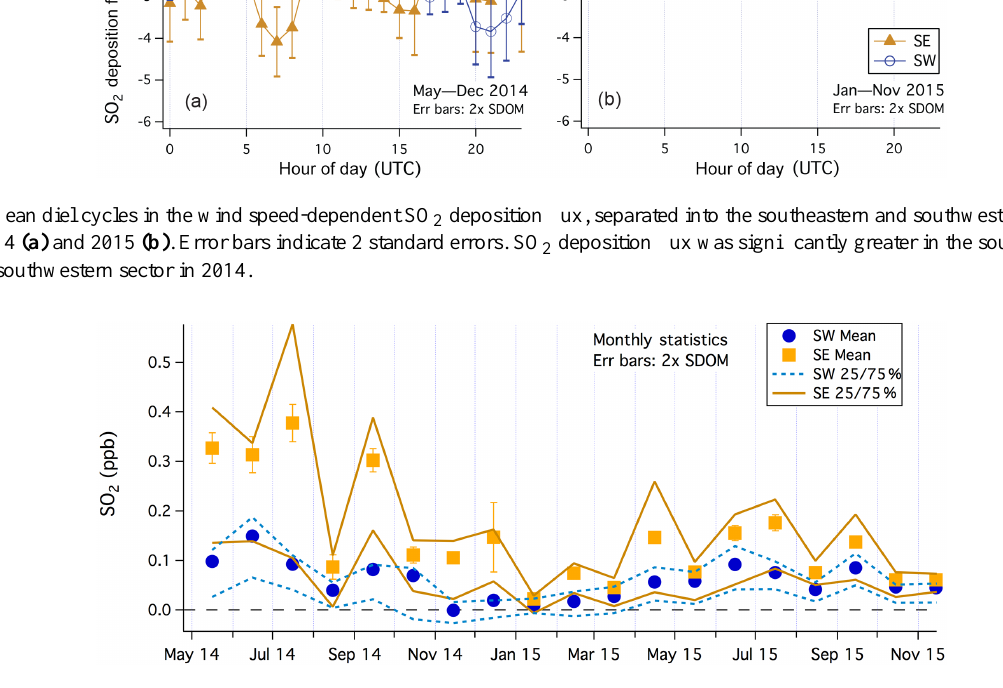
Figure 8. Monthly means and 25th/75th percentiles of SO 2 mixing ratio from southeastern and southwestern wind sectors. SO 2 from the southwest shows a clear seasonal cycle, with higher values in summer/early autumn and lower values in winter/early spring. A similar underlying seasonal variability is also apparent in SO 2 from the southeastern